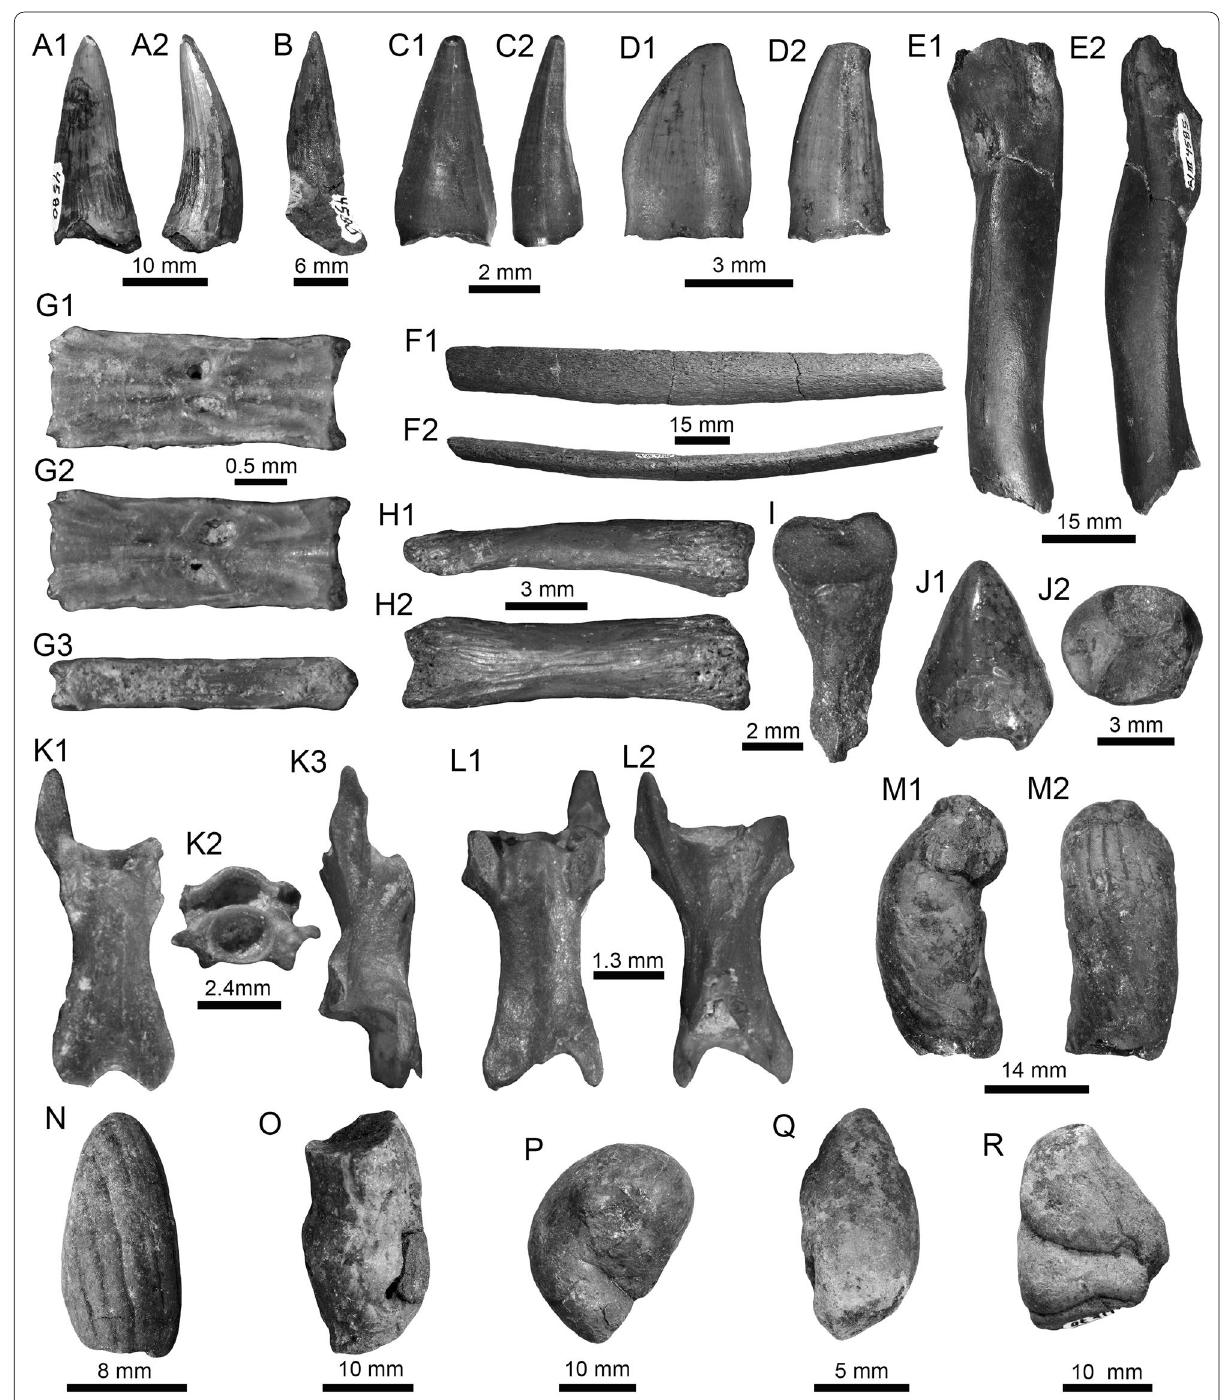
Fig. 11 Crocodylia and other indeterminate vertebrate remains and coprolites from the Iquitos assemblage. A1 – B Gryposuchine gavialid teeth (PIMUZ A/III 4580). C1 – D Crocodylia indet. teeth ( C1 – C3 : PIMUZ A/III 4588; D1 – D2 : PIMUZ A/III 4593). E1 – E2 Right femur (PIMUZ A/III 4585). F1 – F2 Fragment of a posterior thoracic rib (PIMUZ A/III 4586). G1 – G3 Caudal vertebra of probable lizard (PIMUZ A/III 4618). H1 – J Complete ( H1 – H2 : PIMUZ A/III 4619), partial ( I : PIMUZ A/III 4617), and an ungual ( J1 – J2 : PIMUZ A/III 4598) phalanges. K1 – L2 Reptilian vertebrae of uncertain taxonomy (PIMUZ A/III 4597). M1 – R . coprolites (PIMUZ A/III 4570). Views: dorsal ( F2 , H2 , I , J1, K1, L1 ), labial ( D1 ), lingual ( A1 , B , C1 ), lateral ( A2 , C2 , D2 , E1 ), left lateral ( H1, K3 ), posterior ( E2 , J2, K2 ), ventral ( L2 ), and indet. ( F1 , G1 – G3 , K1 – P